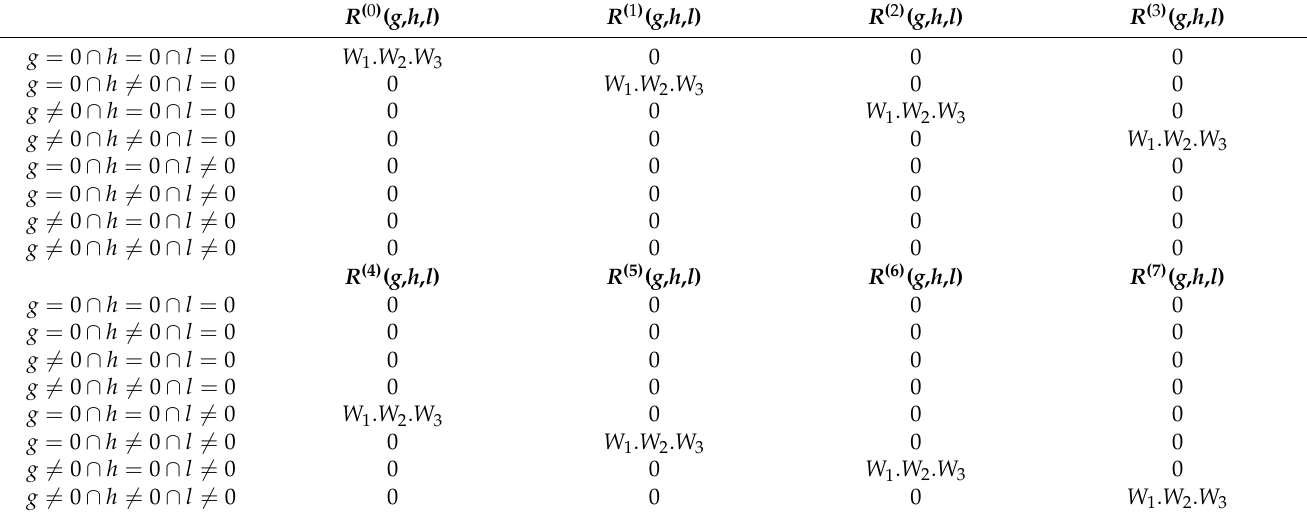
Table 4. Cross correlation values of 3D-VWZCC